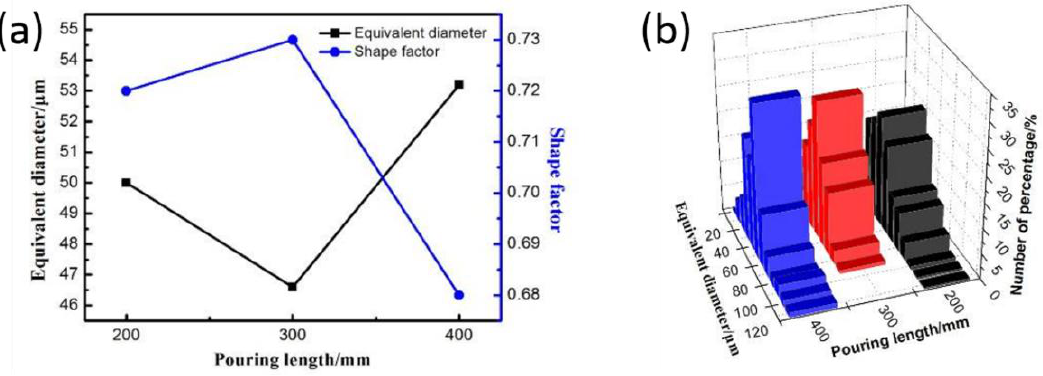
Figure 8. Relationship between equivalent diameter and shape factor of primary α-Cu phase with pouring length ( a ); and distribution of primary α-Cu phase equivalent diameter ( b ) at different pouring lengths of semi-solid ZCuSn10P1 alloy.